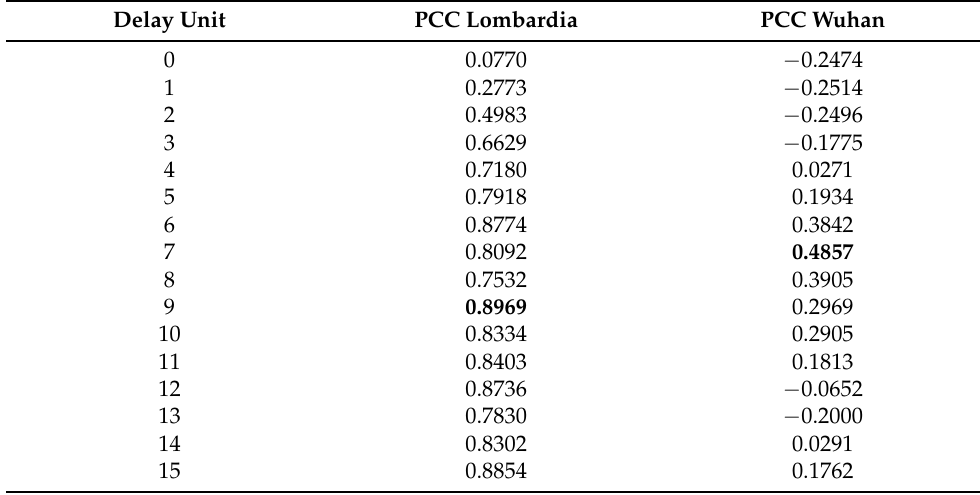
Table 1. Pearson correlation coefficient for Lombardia and Wuhan (maximum correlation in bold). Delay Unit PCC